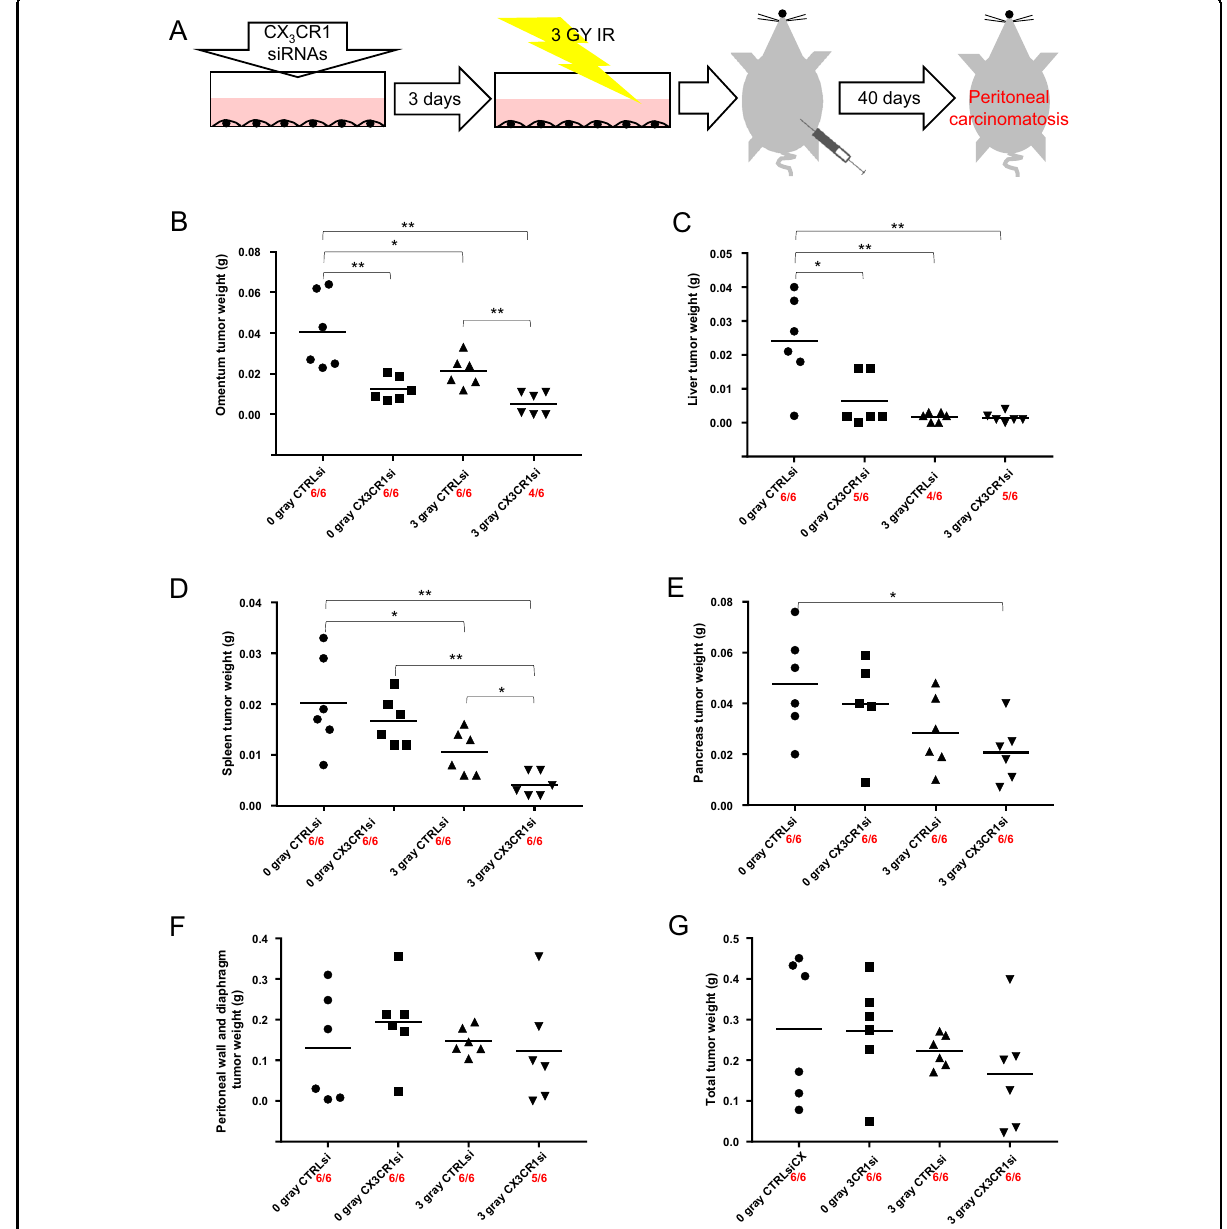
Fig. 6 Transient downregulation of CX 3 CR1 coupled with x-ray radiation affects tumor burden at metastatic sites in the peritoneal cavity. a A schematic of the experimental setup depicting the sequence of experimental steps: SKOV-3 cells were transiently transfected with CX 3 CR1-speci fi c siRNAs and subjected to 3 gray x-ray on the third day after transfection, cells were collected immediately and injected into the abdomens of athymic nude mice; tumors were allowed to form for 40 days. Tumors formed on the omentum ( b ), liver ( c ), spleen ( d ), pancreas ( e ), peritoneal wall and diaphragm ( f ), as well as the total burden ( g ), as indicated, were collected, weighed, and weights plotted on the graphs. The data were statistically analyzed between all groups with one-way ANOVA; the data between two groups were analyzed using Tukey HSD, Scheffe, Bonferroni and Holm, and Mann − Whitney U tests; * p < 0.05, ** p < 0.001. The number of animals presenting with metastasis out of total number of experimental animals in each group is shown in red numbers below